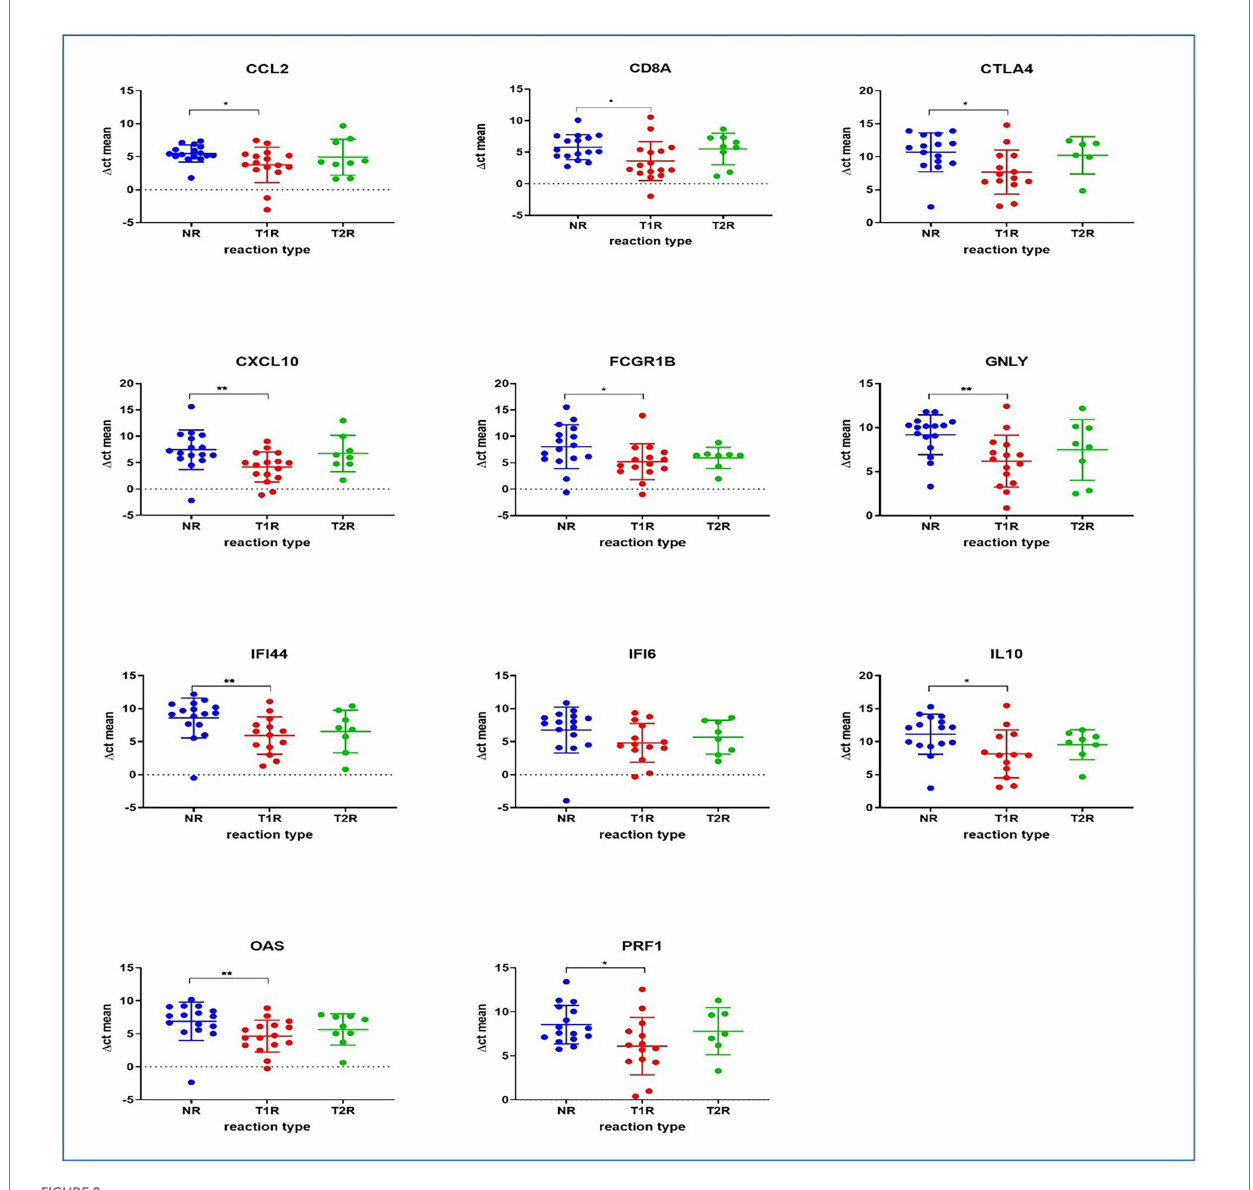
FIGURE 8 The panel depicts immune gene expressions across the study groups as determined by qPCR. Statistically significant differences in mean of the ∆ Ct for technical replicates of each of the sample was denoted by * for value of p of 0.05 and ** for value of p of